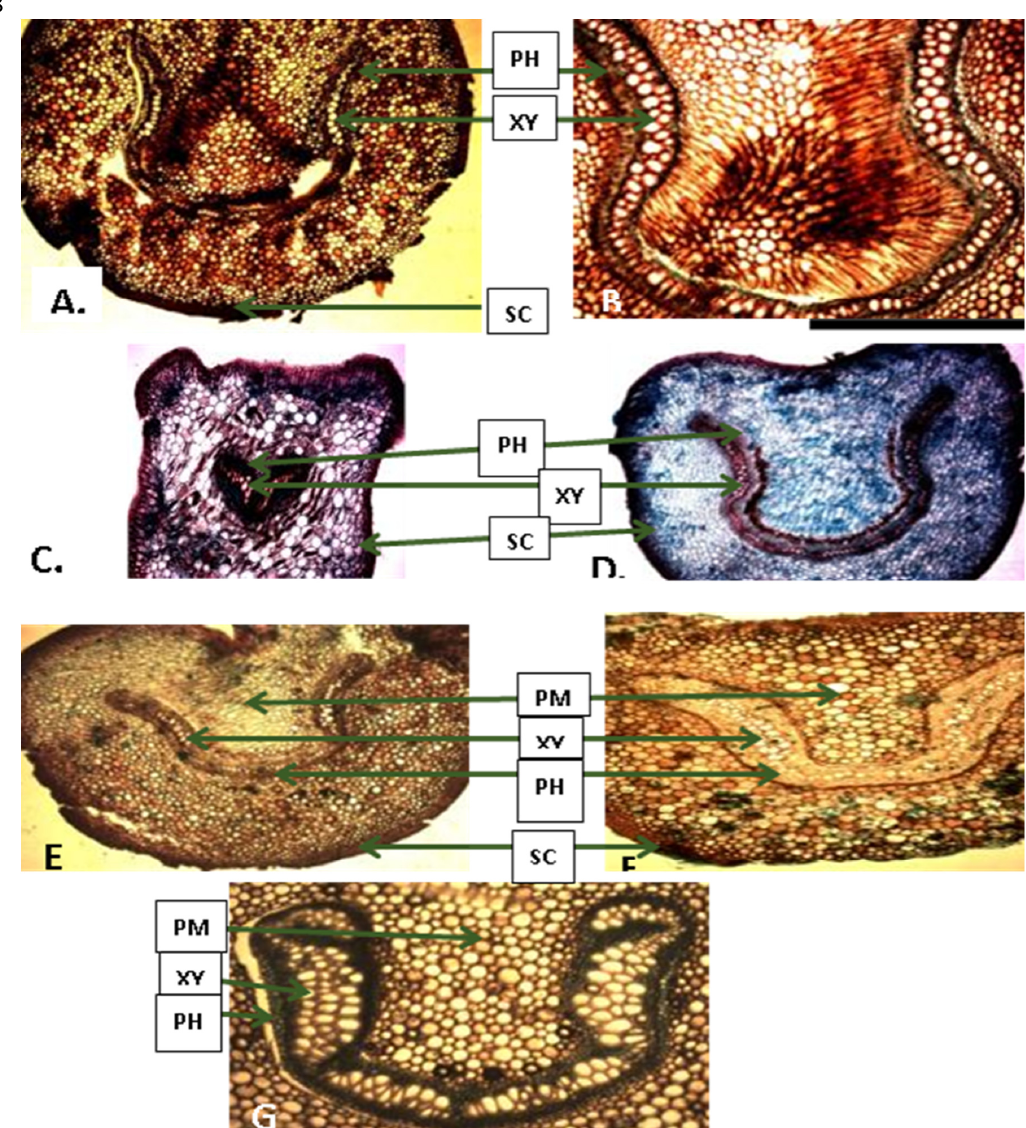
Figure 5. Transverse sections of median regions of stipes showing cortex in Pteris species. A: P. acanthoneura , B: P. atrovirens , C: P. ensiformis , D: P. mildbraedii. E : P. similis, F: P. togoensis, G : P. vitatta Legend: SC: Sclerenchyma, PH: Phloem, XY: Xylem, PM: Parenchyma, CO: